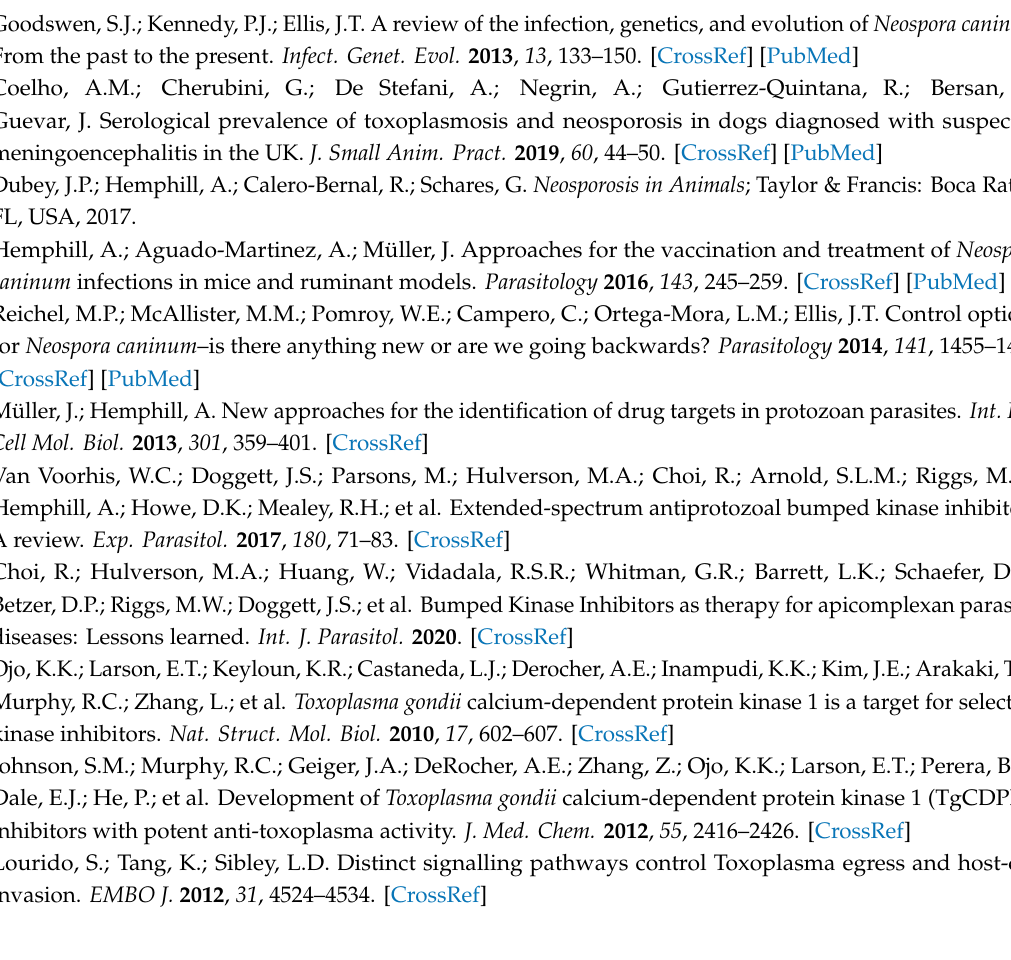
Table S1. Proteome data set of N. caninum tachyzoites and of MNCs induced by BKI-1294 treatment of infected cells. Parasites were grown and subjected to MS shotgun analysis as described in the Materials and